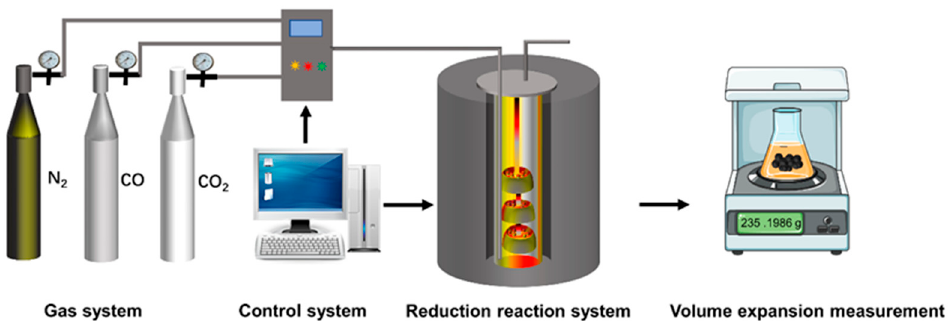
Figure 3. The experimental process of the reduction swelling index test.